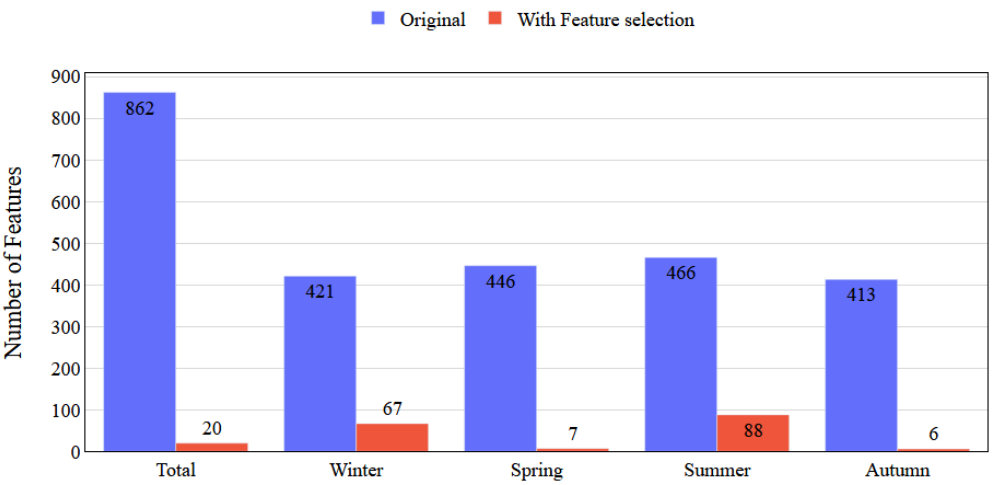
Figure 4. Feature selection results.